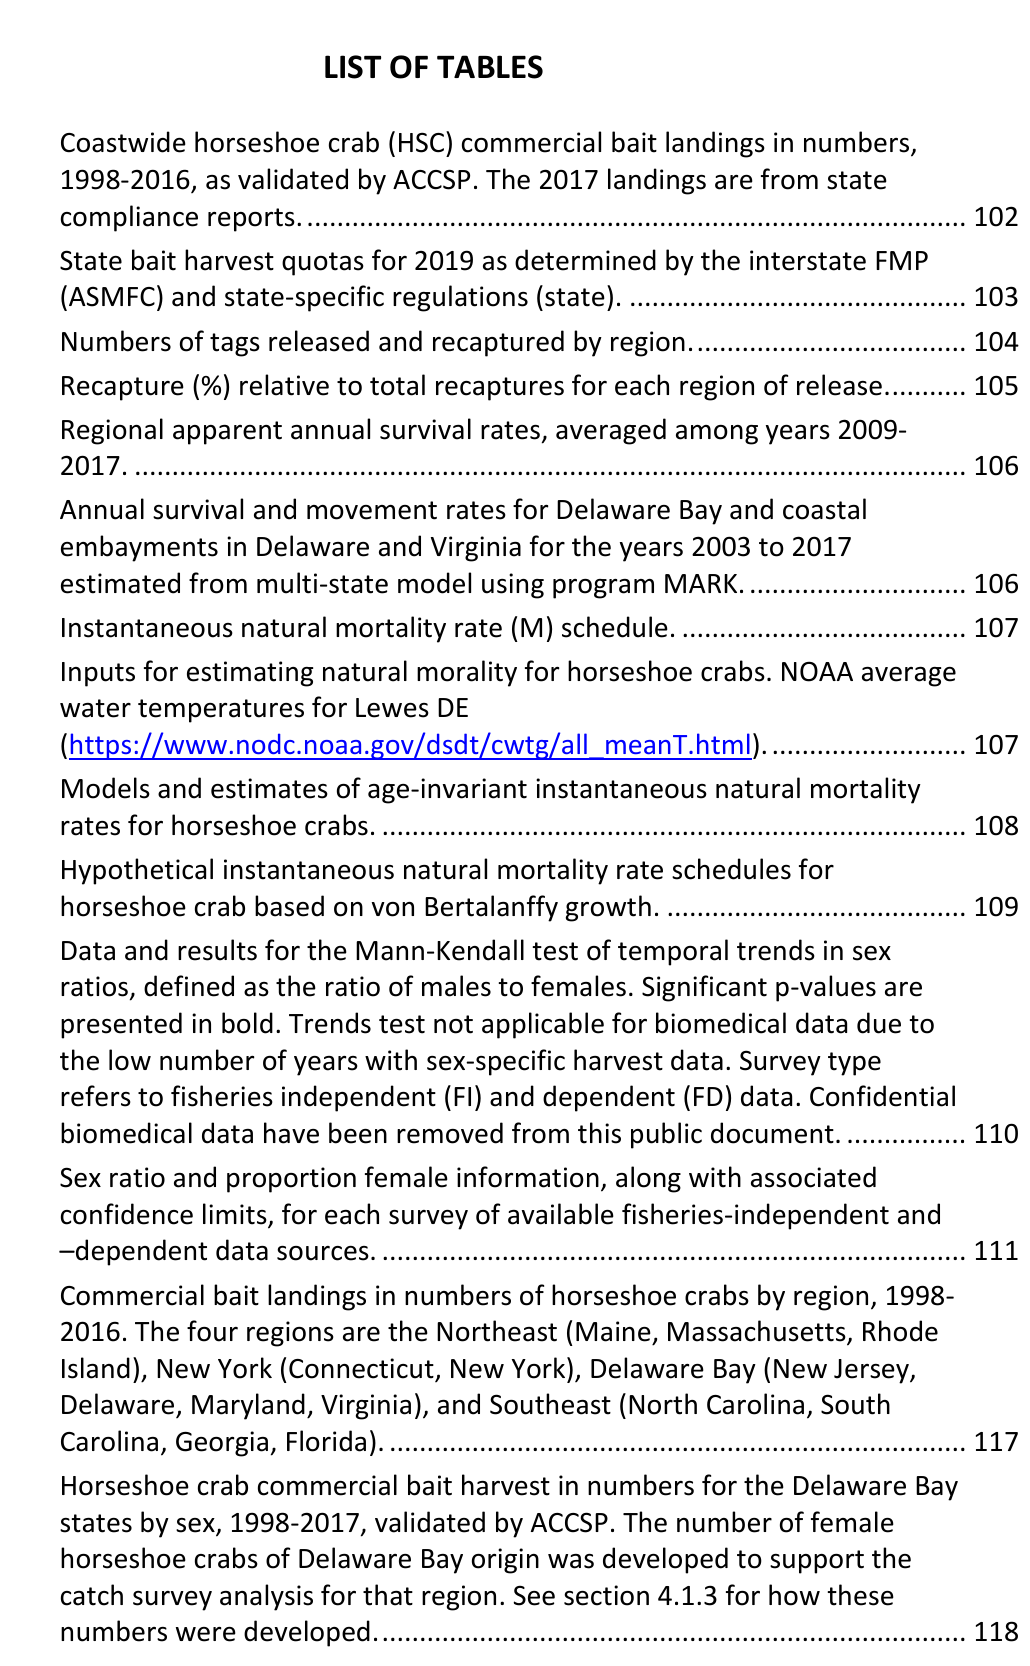
2019 Horseshoe Crab Benchmark Stock Assessment Non-Confidential Report